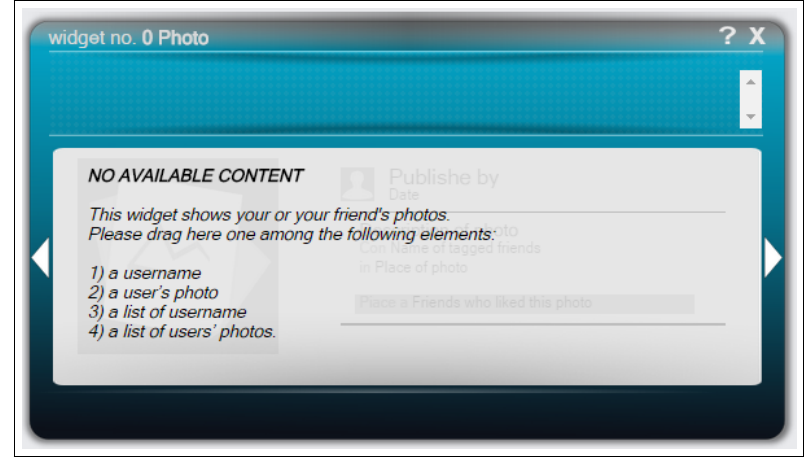
Figure 5. A photo widget immediately after adding it into the